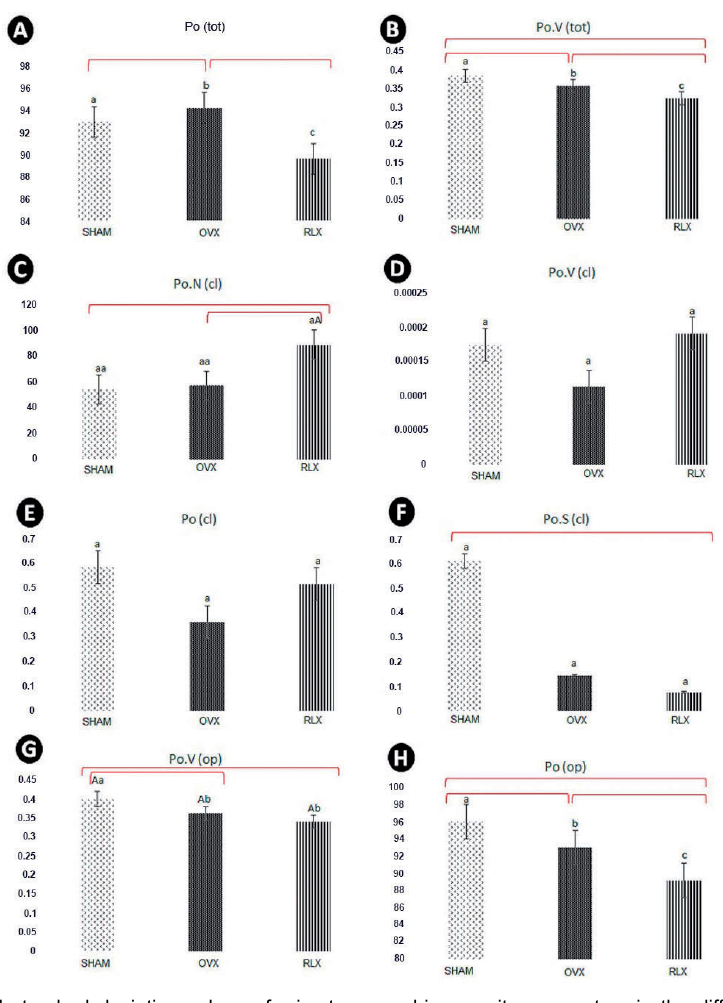
Figure 8- (A-H) Mean and standard deviation values of microtomographic porosity parameters in the different experimental groups (SHAM, OVX, and RLX) at 60 days after implant placement. Different letters a, b, or c, as well as difference between lower and upper-case letters show statistically significant difference between groups, according to parameters analyzed (P<0.05); same letters and lowercase letters represent similarity among groups (P>0.05) for each parameter analyzed